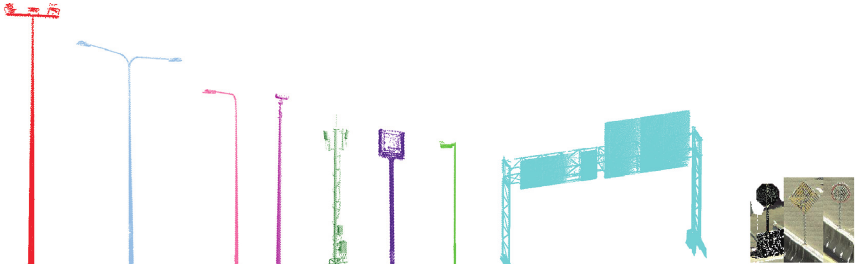
Figure 10: Expressway facilities being classified (from left to right) as high-mast lighting, lighting pole-2-sided, lighting pole-1-sided, CCTV camera, telecommunication tower, speed limit pole, lighting pole-1-sided (special type), overhead sign, and some types of small Table 1: Parameter settings for PLO classification.